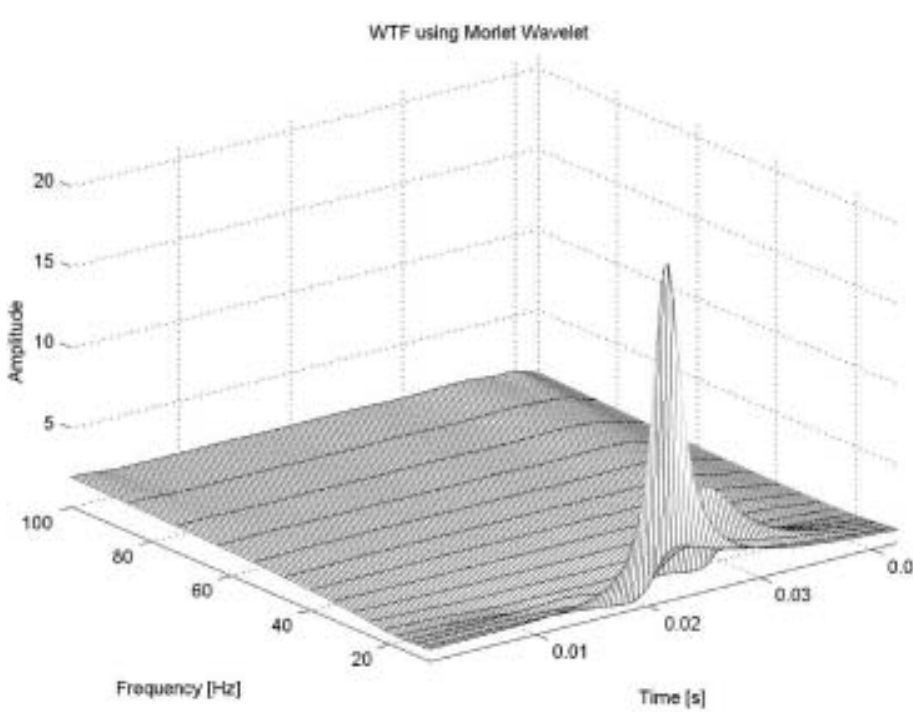
Fig. 3. WTF for both Simulated Healthy and Damage beam from Node 5.